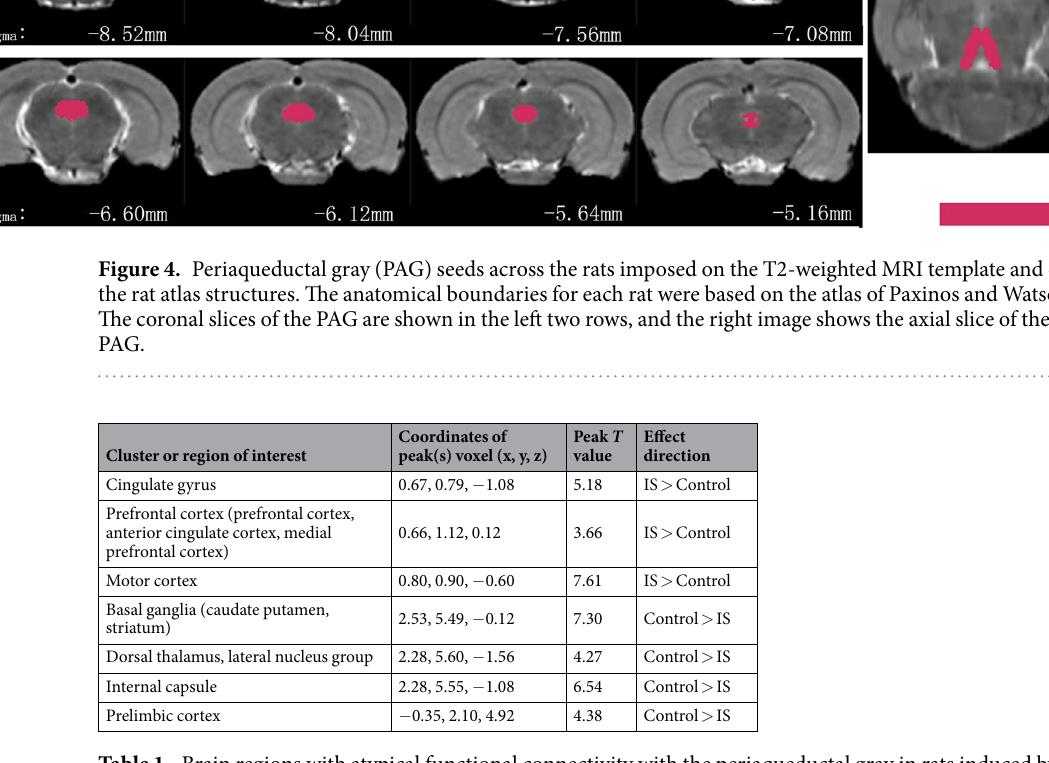
Table 1. Brain regions with atypical functional connectivity with the periaqueductal gray in rats induced by dural inflammatory stimulation. Regions with changes in functional connectivity with the periaqueductal gray were found in rats induced by subcranial (supradural) infusion of inflammatory soup compared with saline- treated control rats. The coordinates according to Paxinos and Watson 40 are given in